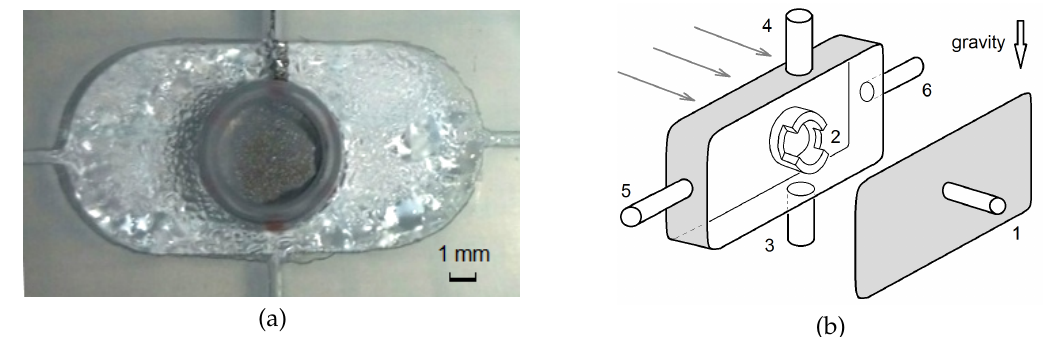
Figure 7. ( a ) Photograph as general view of the reaction zone of the continuous-flow microreactor with an adaptive mixing effect due to an air bubble placed in the center. ( b ) Scheme of the cuvette: inlet for air to produce the bubble 1; plastic insert to hold the bubble 2; inlets for the reagents 3 and 4; outlets for the reaction product 5 and 6. Arrows indicate the direction of observation with the Fizeau interferometer.